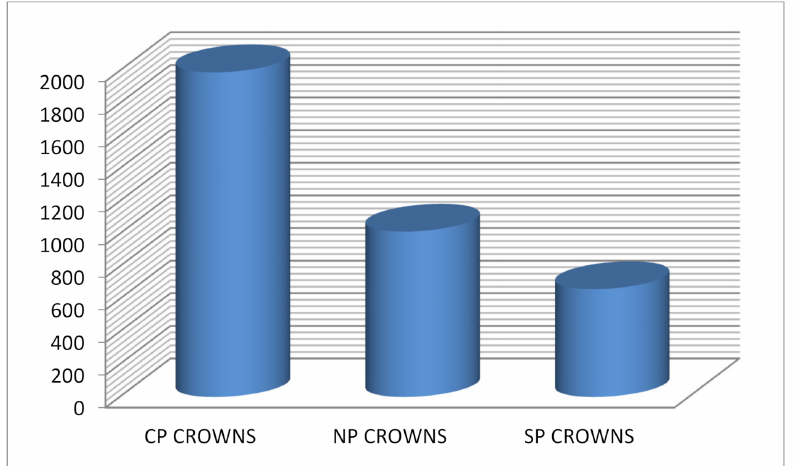
Figure 2. Shows mean load observed at posterior region among different types of crowns.